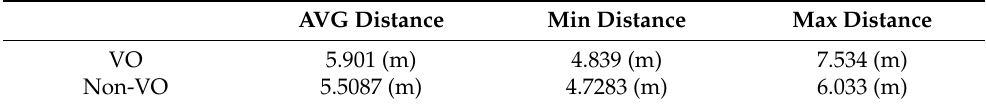
Table 3. Comparison of navigation distance.